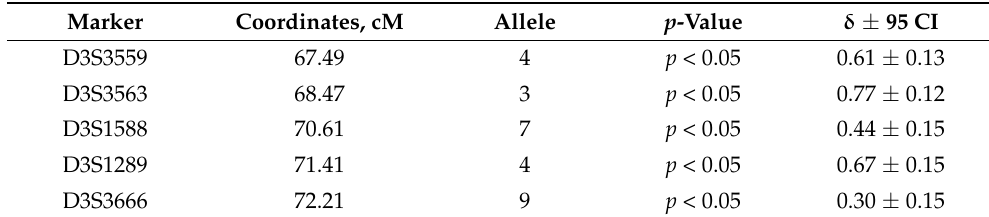
As a comparison group, we genotyped the DNA samples of 34 non-related Dargins who were without the c.3577del mutation, by using the same microsatellite markers. We determined the frequency of alleles in 16 carrier (D) chromosomes of homozygotes and 68 control chromosomes (N) for the 5 microsatellite loci positioned above (D3S3559 and genetic map. The F-test results for the alleles of the markers with the highest linkage disequilibrium values δ are presented in Table 2. Table 2. Linkage disequilibrium analysis between COL7A1 c.3577del mutation and microsatellite markers close to the COL7A1